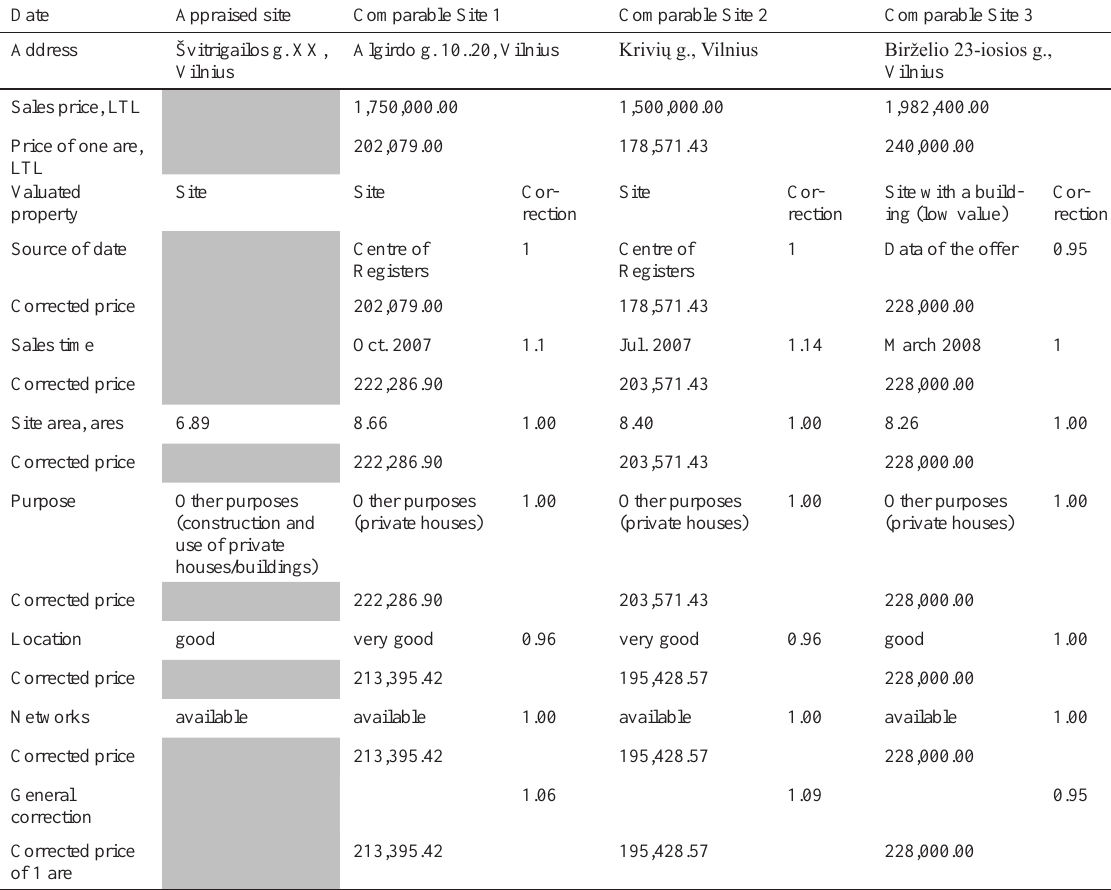
table 4. Comparative data